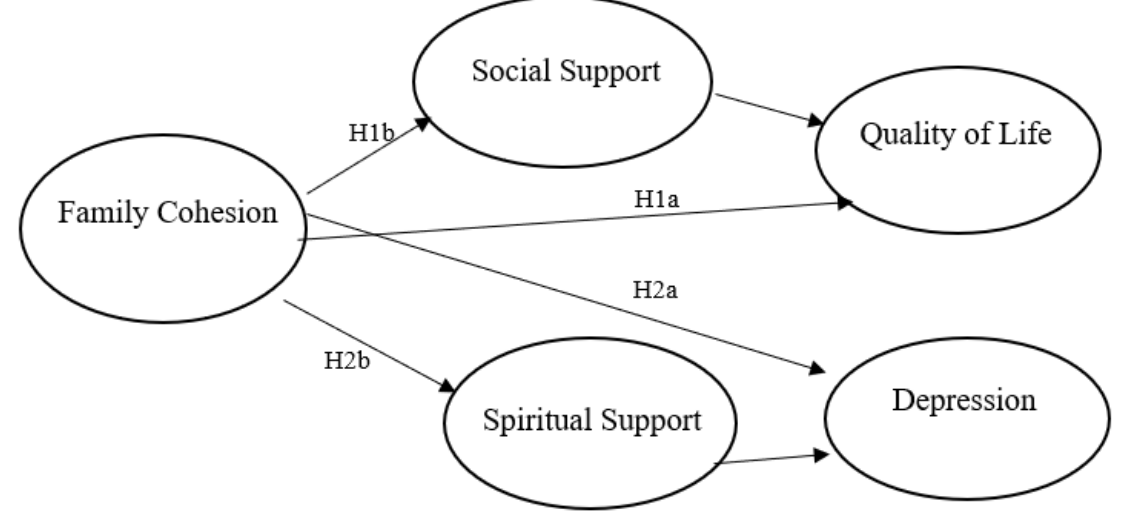
Figure 1. Conceptual model with relationships between key variables (Hypotheses